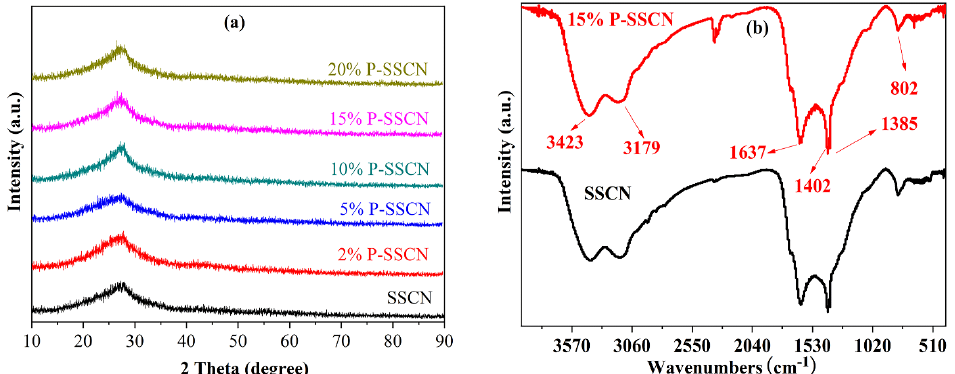
Figure 1. ( a ) SSCN XRD patterns and x%P-SSCN (x = 2, 5, 10, 15, 20) with different mass percentages of solid phosphorous acid, ( b ) FTIR spectra for SSCN and 15%P-SSCN.